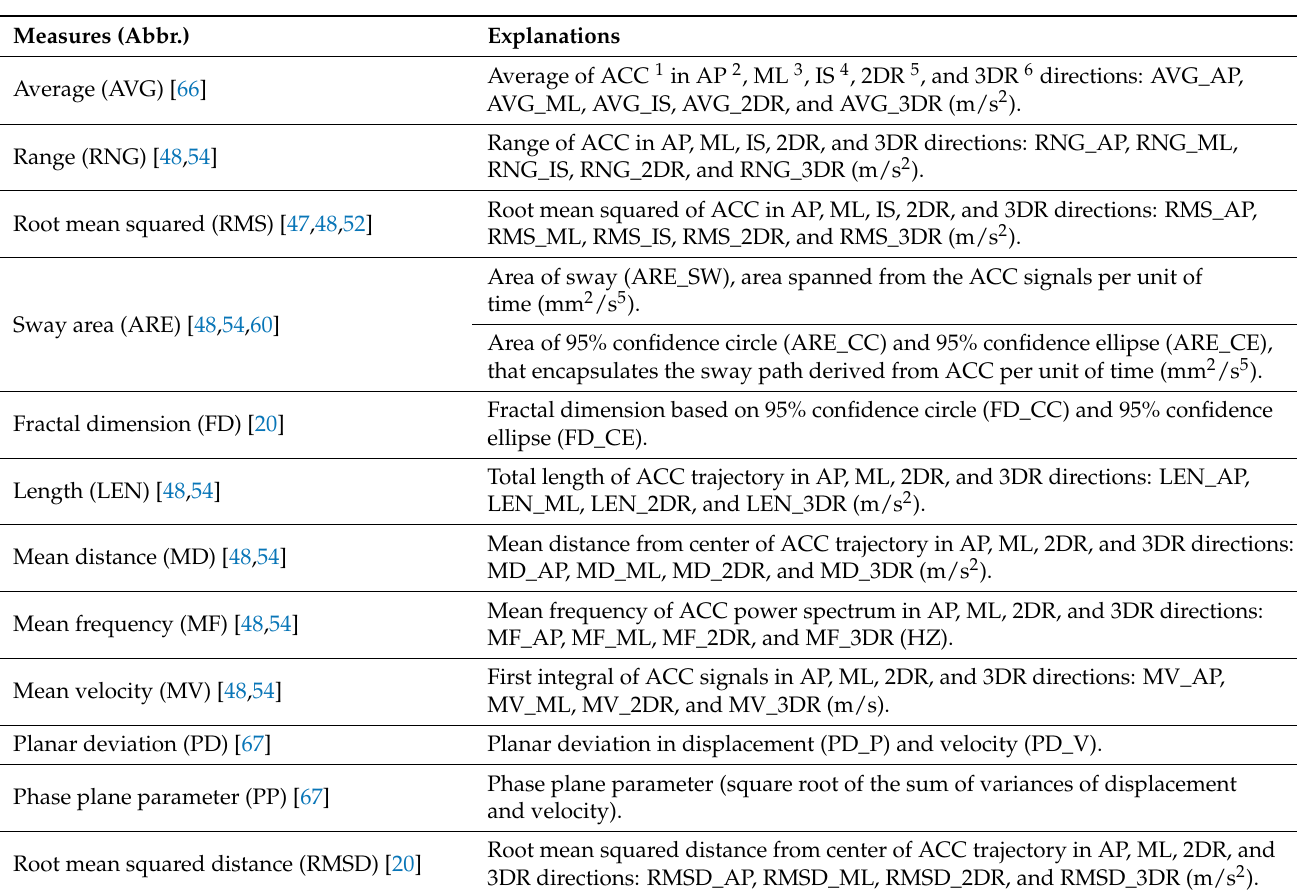
Table 1. Acceleration based postural stability measures adopted in this study.